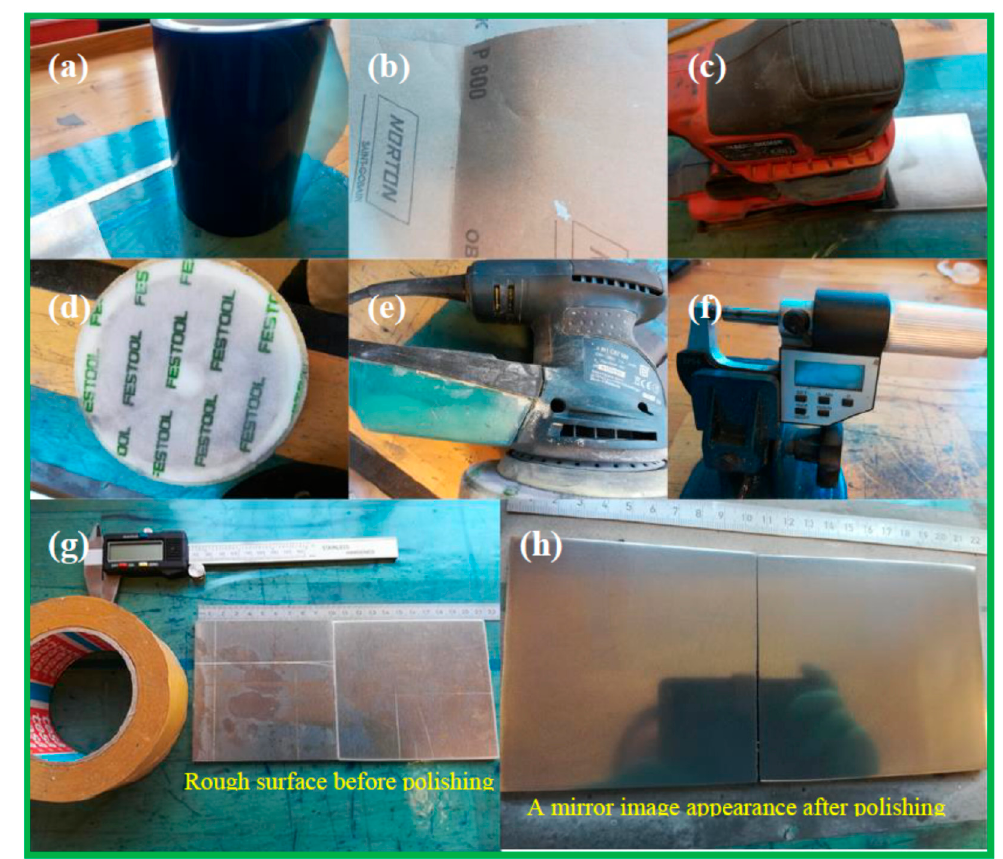
Figure 3. Digital pictures of the steps taken to polish the back of the Al plate. ( a ) Blue tape to cover the table surface and workplace; ( b ) sand paper Norton P 800; ( c ) Black Decker Duosand to sand the surface; ( d ) polishing sponge; ( e ) the Bosch GEX 125-1 AE machine that runs the polishing sponge; ( f ) Electronic IP54 Outside Micrometer; ( g ) and ( h ) show the Al plate, before and after polishing, respectively.